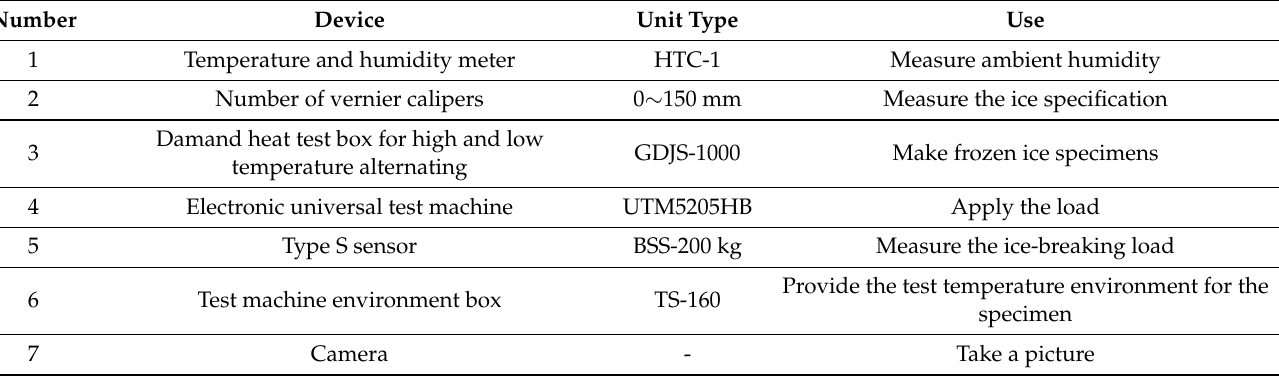
Table 4. Test equipment and test